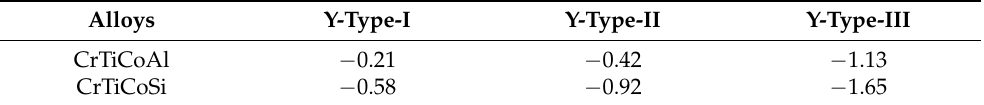
Table 3. Formation energies of both compounds in the three atomic configurations, in eV. Alloys Y-Type-I Y-Type-II CrTiCoAl − 0.21 − 1.13 CrTiCoSi −